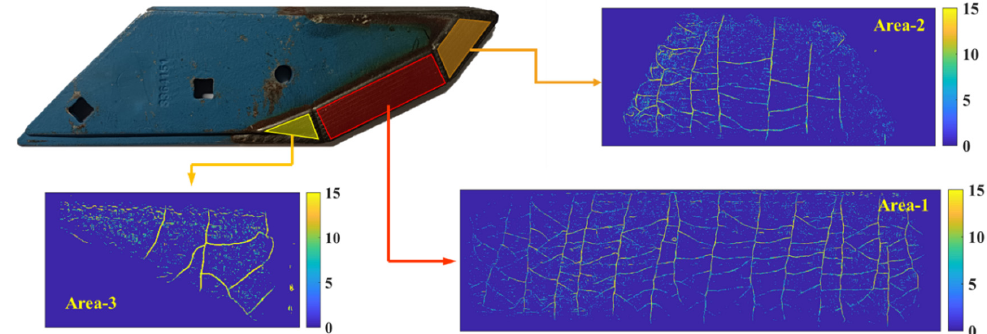
Figure 17. The crack detection results of each part of the repair layer.